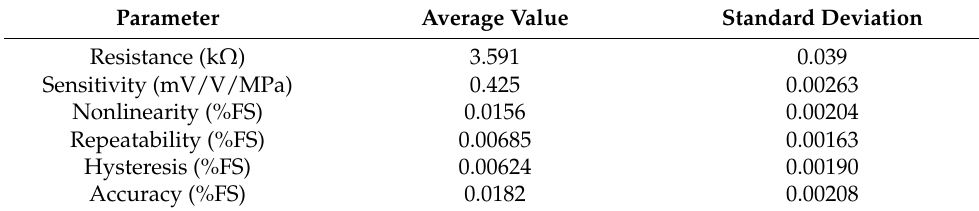
Table 3. Average values of piezoresistive sensors parameters.